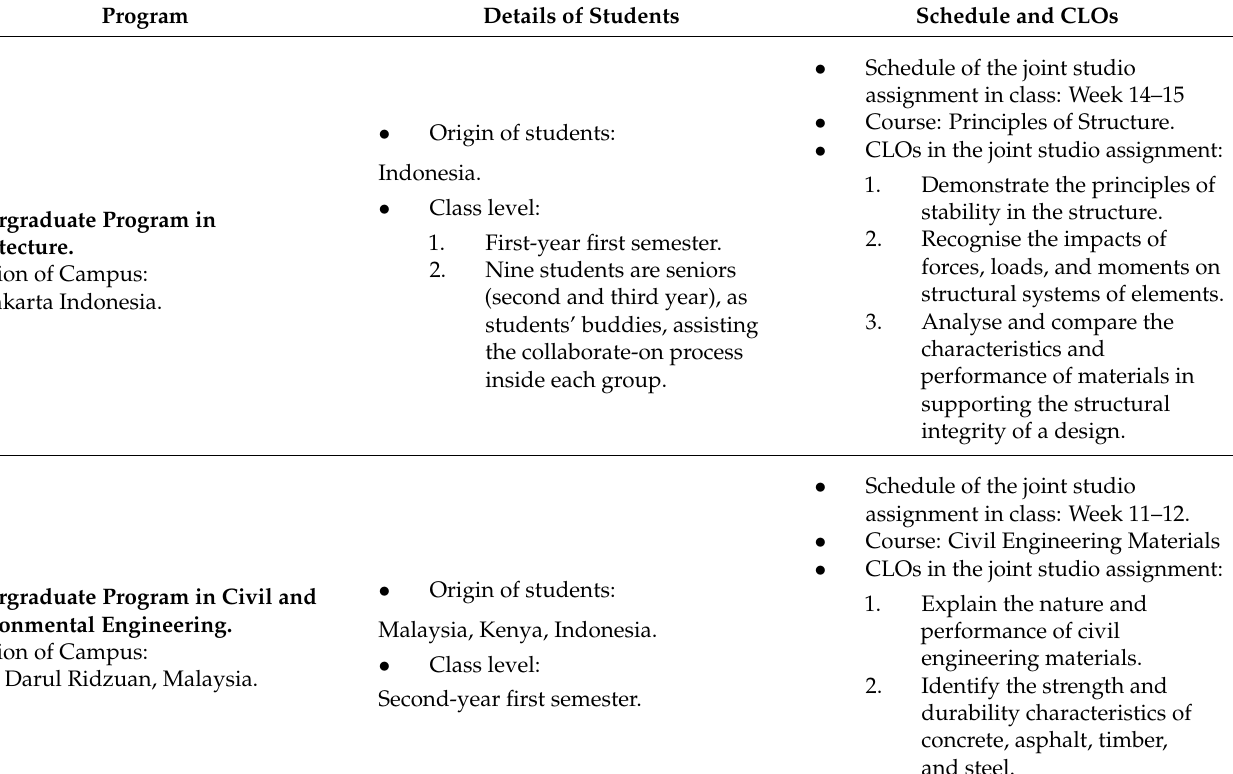
Table 5. Details of program, participants, schedule, and CLO.